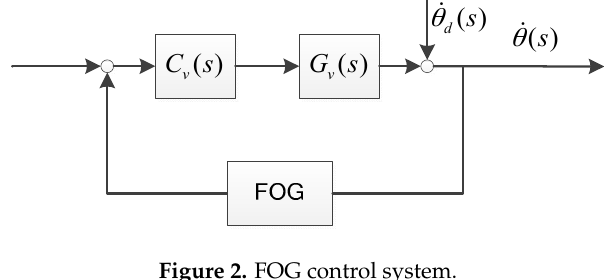
Figure 2. FOG control system.